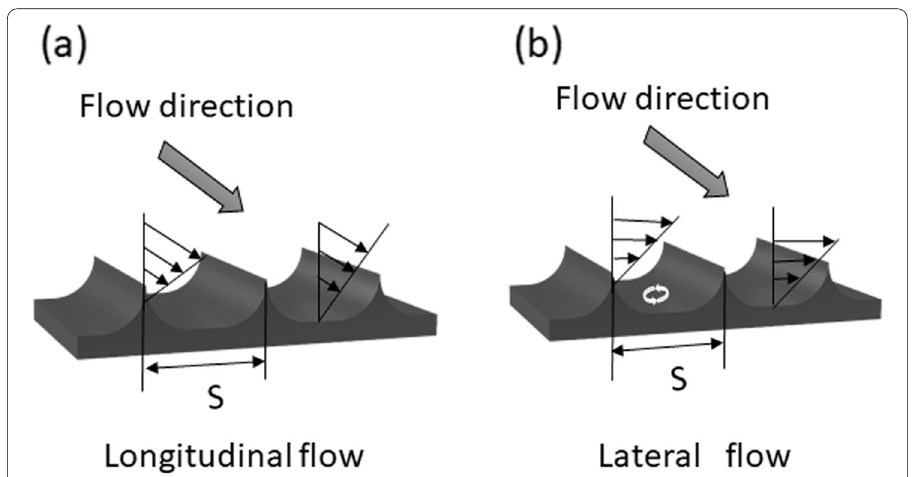
Fig. 3 Viscous flow (longitudinal and lateral components) across